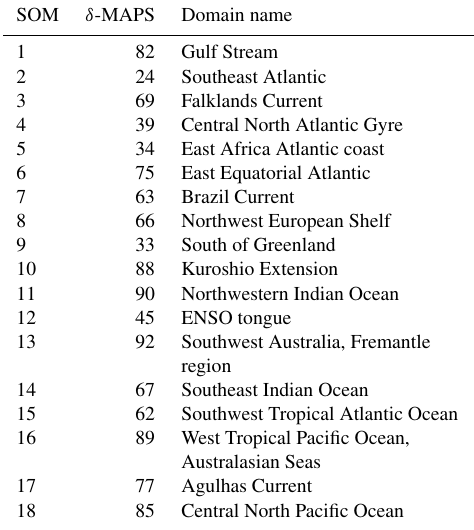
Table A1. Names of SOM and δ -MAPS